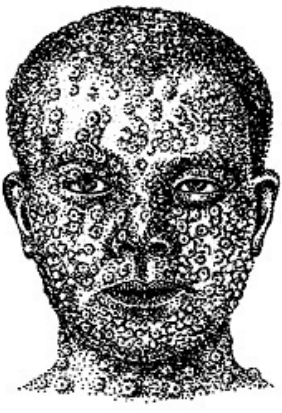
FIGURE 1. Mosaic focal distributions of specific lesions in a case of human